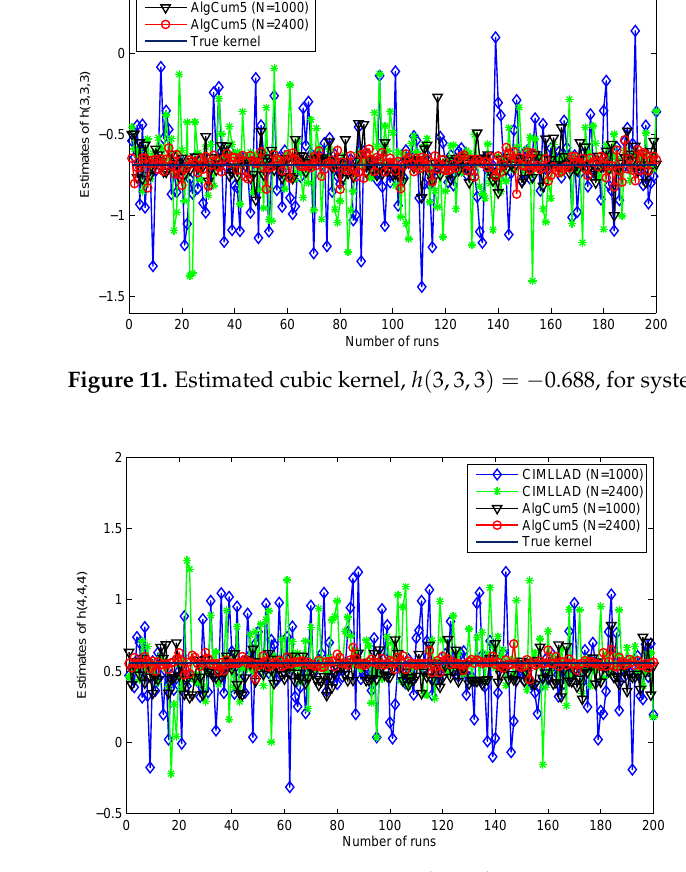
Figure 12. Estimated cubic kernel, h ( 4,4,4 ) = 0.56, for system II.